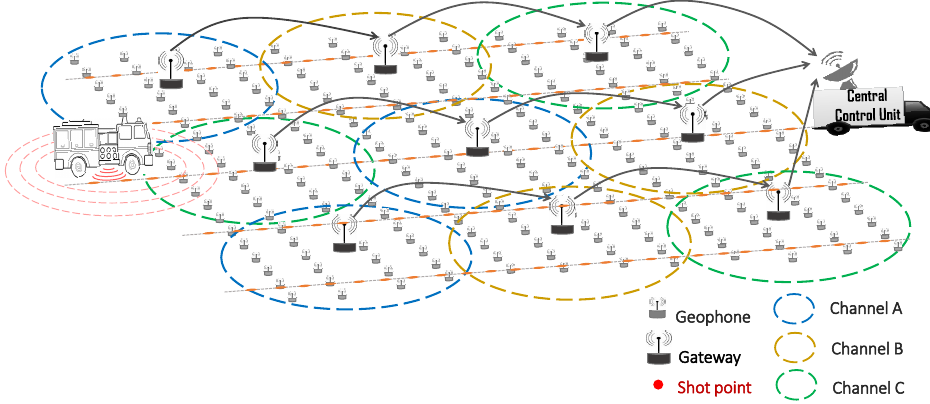
Figure 4. The proposed WGN architecture.